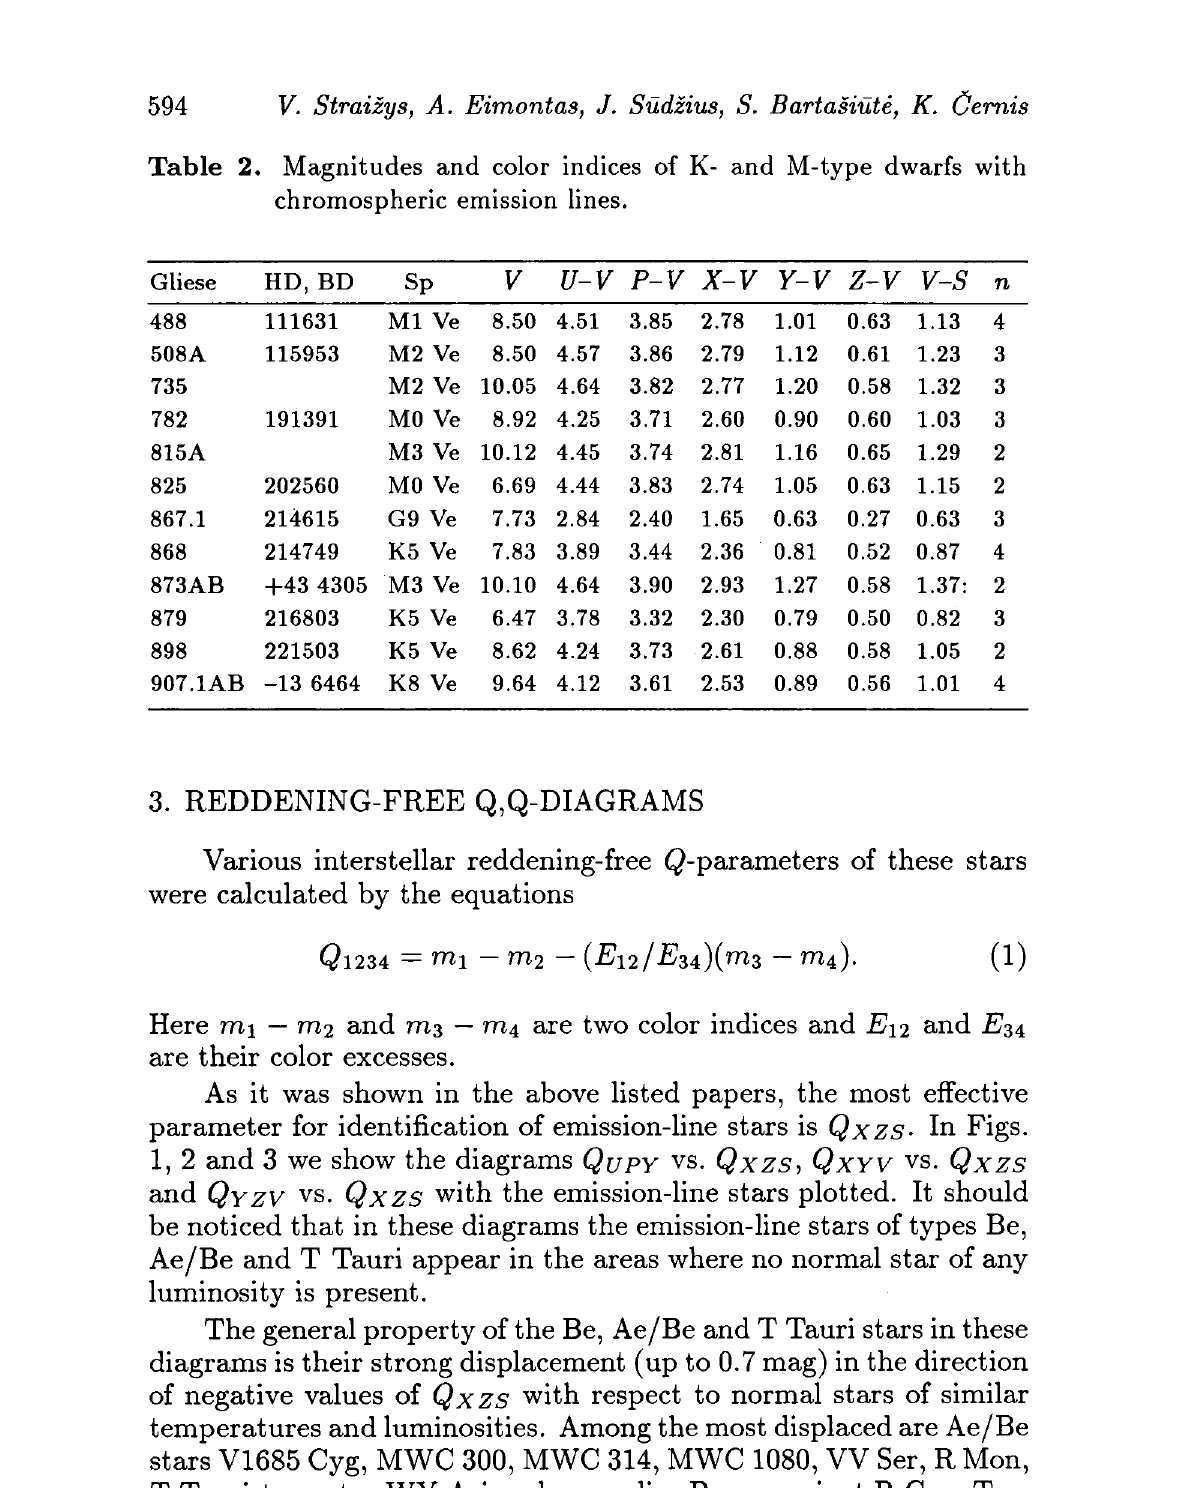
Table 2. Magnitudes and color indices of K- and M-type dwarfs with chromospheric emission